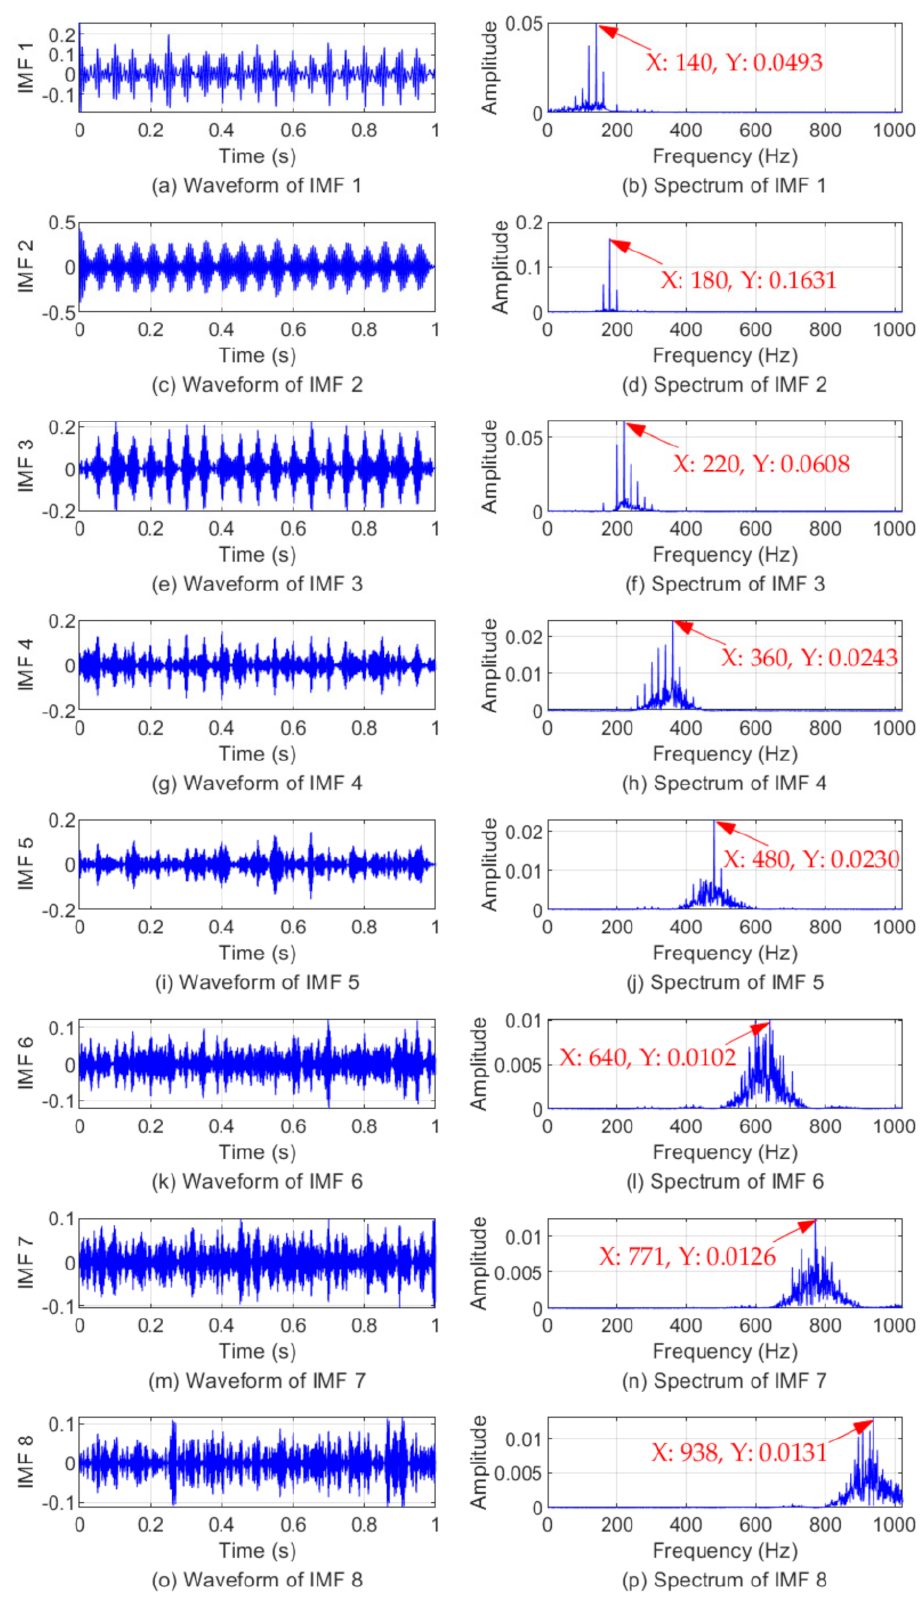
Figure 6. IMFs and their spectra decomposed by